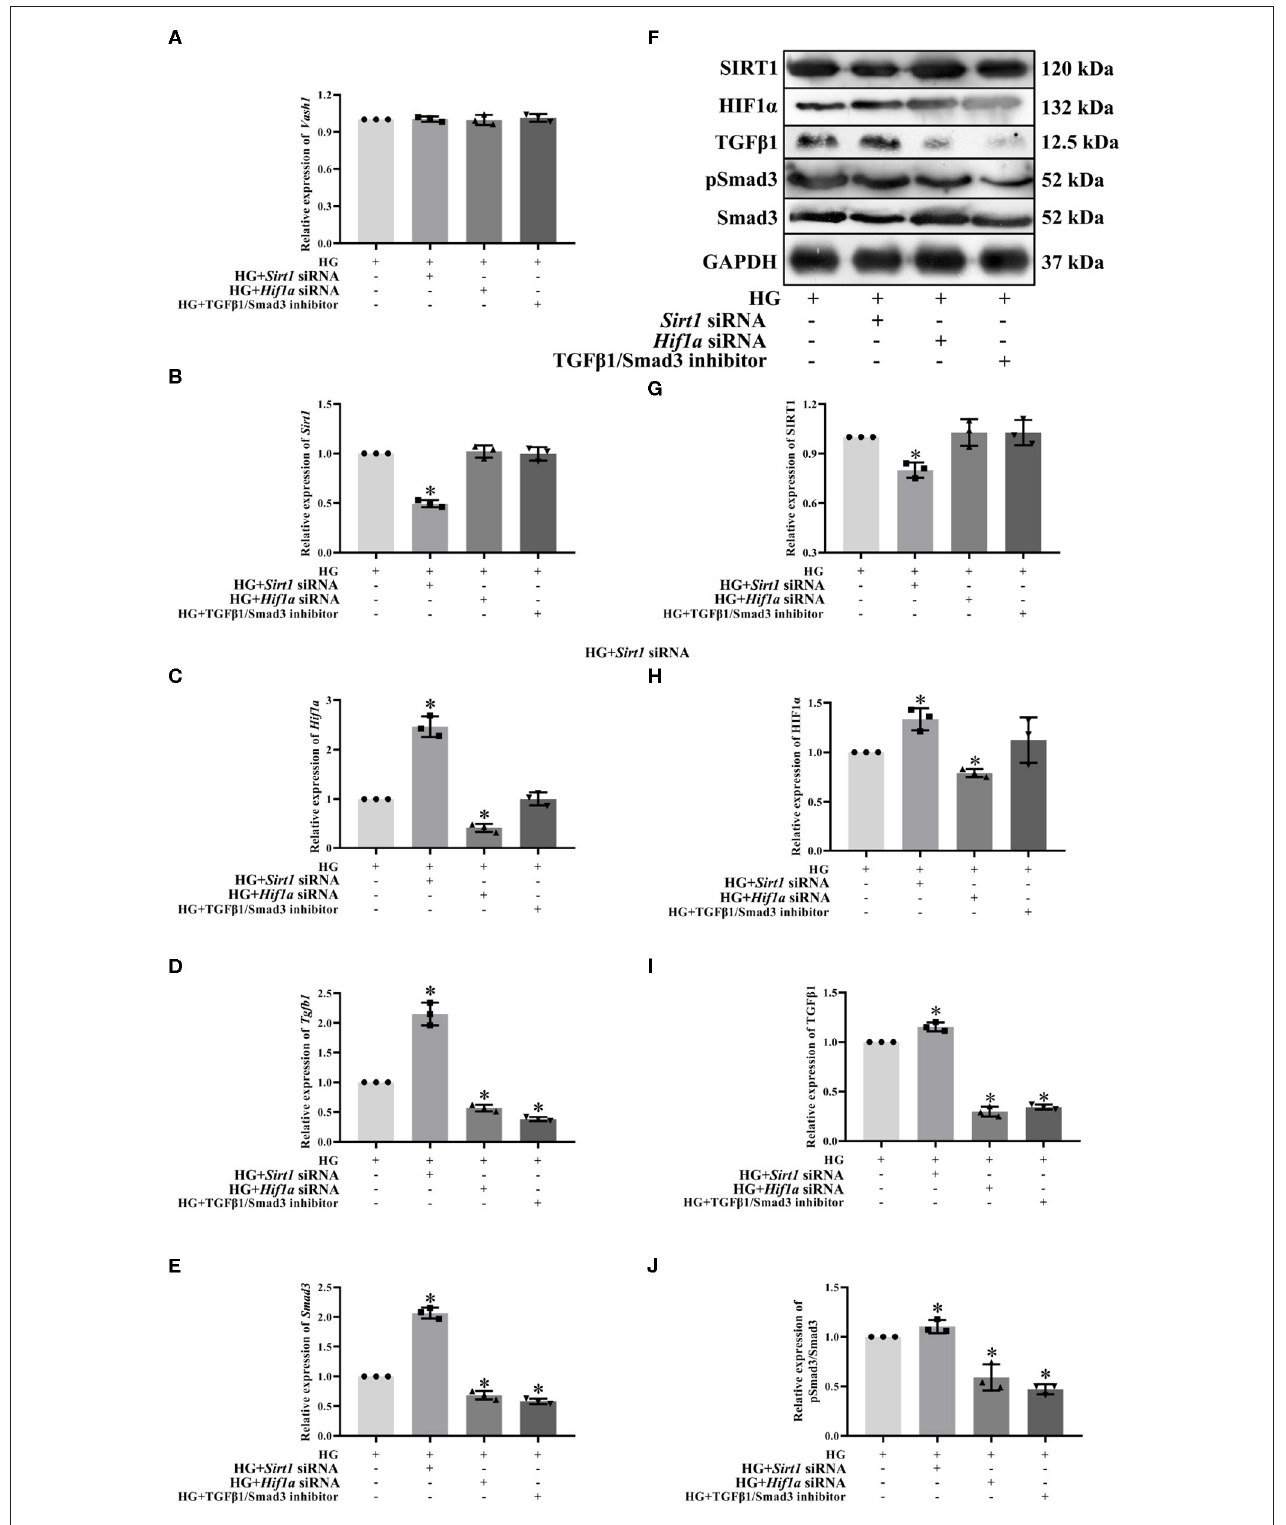
FIGURE 8 | Effect of Sirt1 , Hif1a siRNA, and the TGF β 1/Smad3 pathway inhibitor on pathway expression in high glucose-cultured RMCs. Relative expression levels of (A) Vash1 , (B) Sirt1 , (C) Hif1a , (D) Tgfb1 , and (E) Smad3 mRNA, (F) Western blot protein bands, relative expression levels of (G) SIRT1, (H) HIF1 α , (I) TGF β 1, (J) pSmad3/Smad3. *Compared with the HG group, P < 0.05. Data were expressed as mean ± SD, and results were repeated three times.